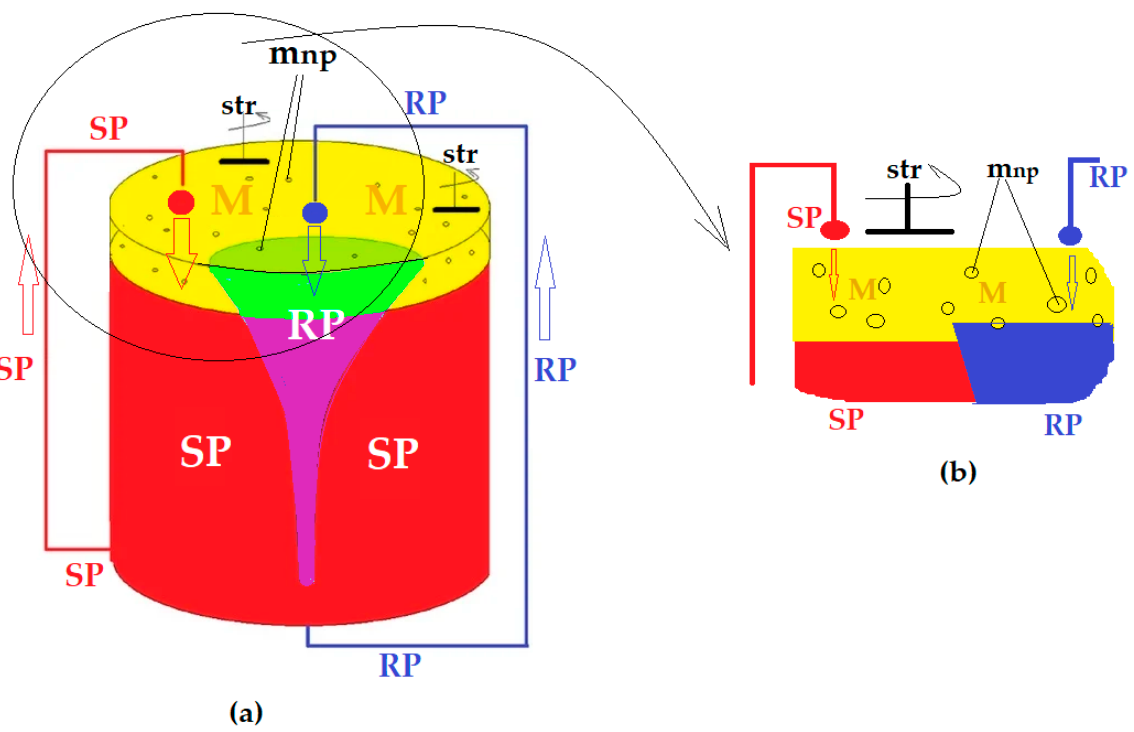
Figure 2. Schematic presentation of the permeation module with dispersed phases: ( a ) general view; ( b ) cross-section detail. SP, source phase; RP, receiving phase; M, organic solvent membrane; m np , magnetic nanoparticles; str, stirrer with magnetic rods.